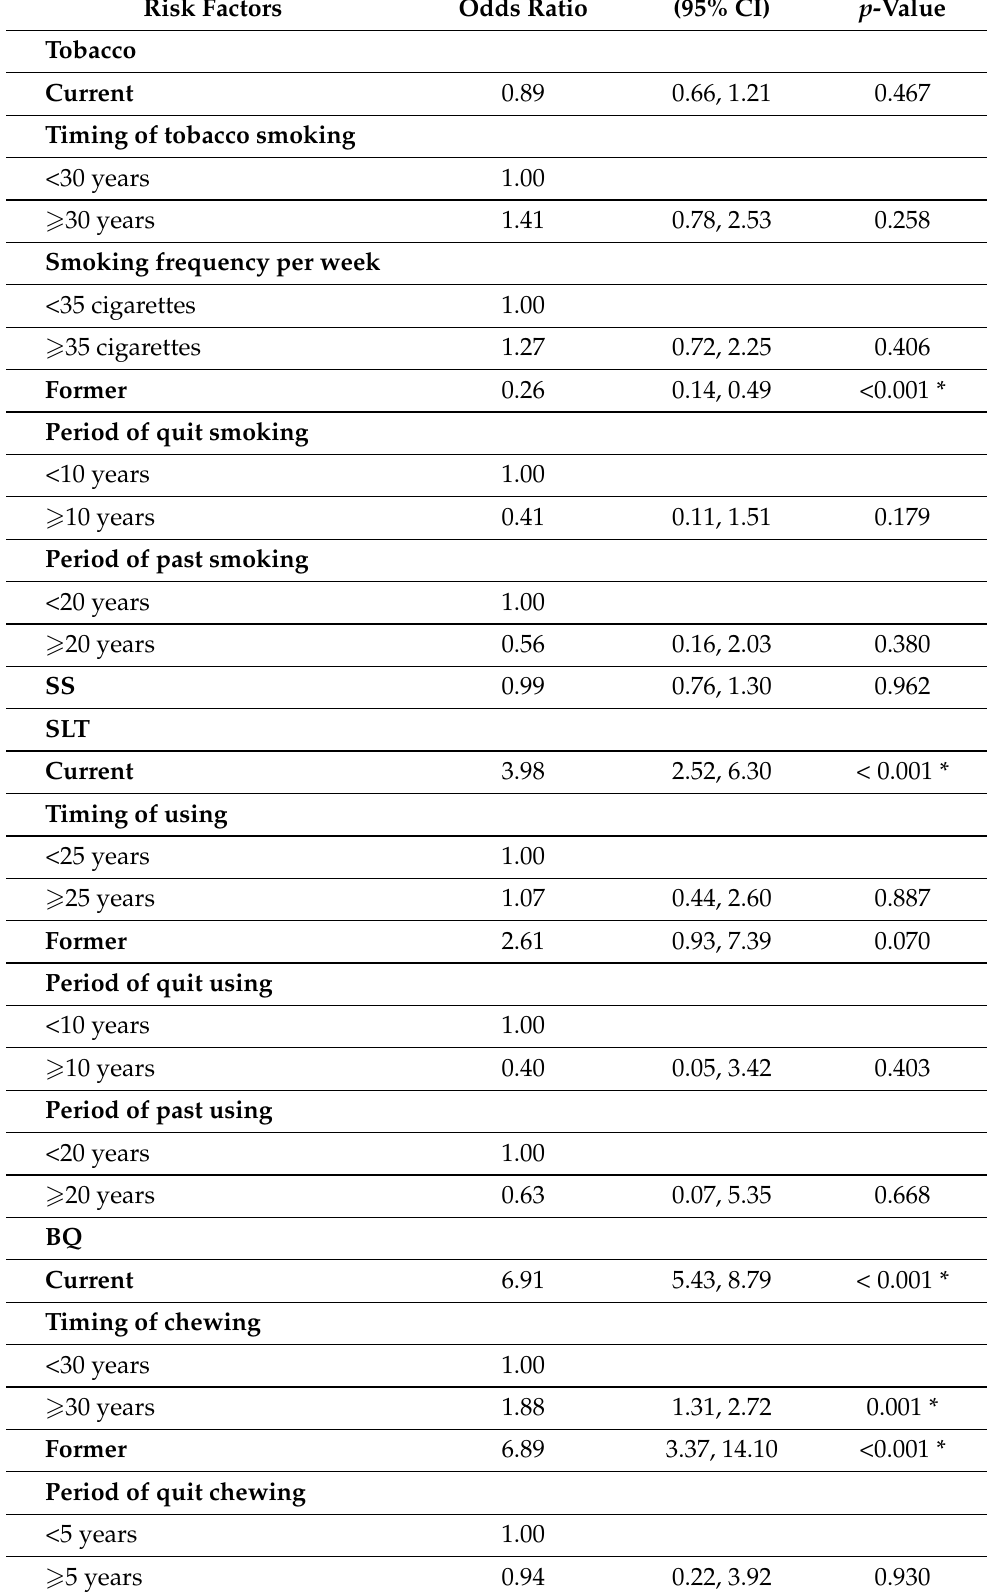
Table 3. Odds ratios of risk factor exposure characteristic with OPMDs